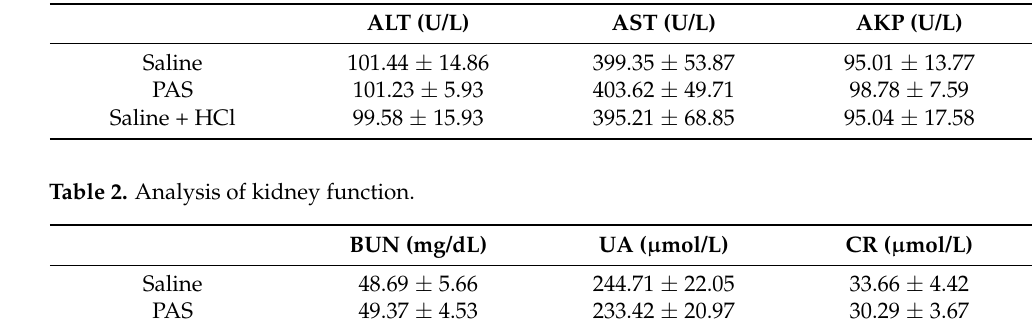
Table 1. Analysis of liver function.